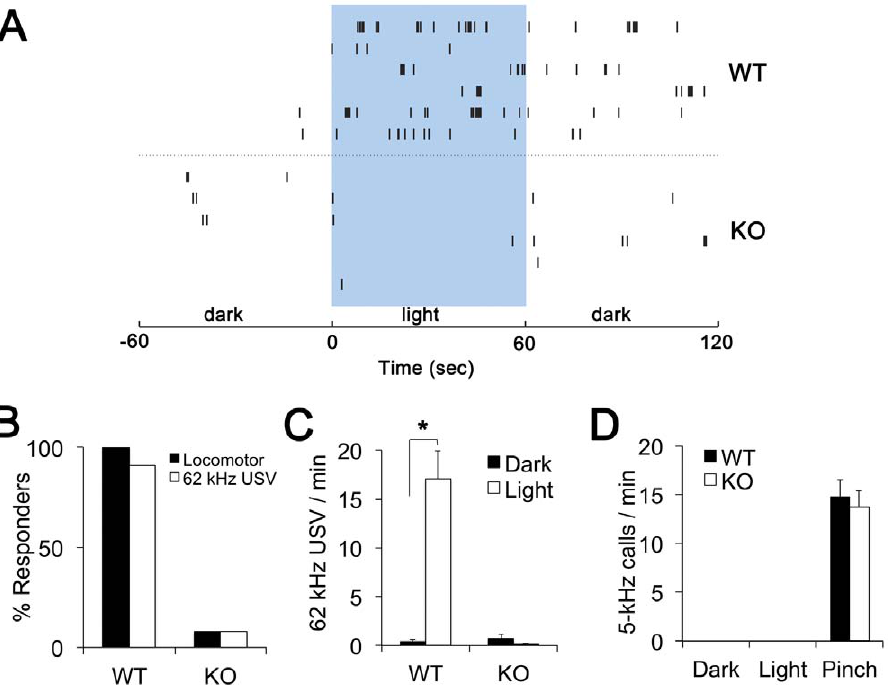
Figure 2. Light evokes aversive but not pain-associated vocalizations in neonatal mice. (A) Raster plots of the 62-kHz USVs from six wild type (WT) and six melanopsin-knockout (KO) pups during one-minute periods before, during and after light exposure. Each tick represents a 62-kHz USV of an individual pup. (B) Percent responders to one-minute light were qualitatively assessed during the experiments. Locomotor response was considered positive if a pup turned around or produced vigorous head pivoting in response to light. No or very little movement was present in either WT or KO pups during one minute prior to light onset. Vocalization response was positive if a pup noticeably increased the number of 62-kHz USVs during exposure to light as compared to baseline. (C) Average number of 62-kHz USVs in the minute prior to turning light on (Dark) and during 1 minute of light (Light) in WT (n=22) and KO (n=13,) pups. The asterisk (*) indicates p , 10 2 5 . (D) Average number of 5-kHz squeals in the minute before and 1 minute after the onset of light or tail pinch in WT (n=8) and KO (n=10) pups. No 5-kHz squeals were present at any time during isolation, acclimation and light stimulation. Data are presented as mean values 6 SEM.